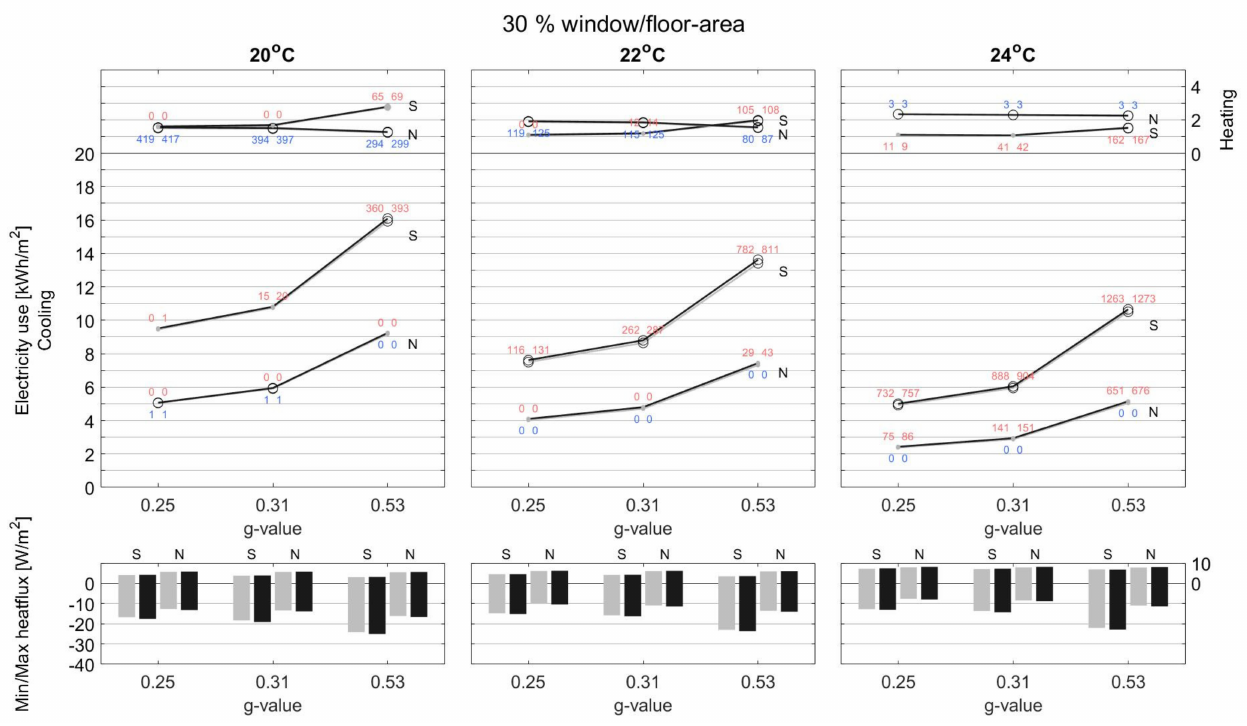
Figure A1. Copenhagen office.